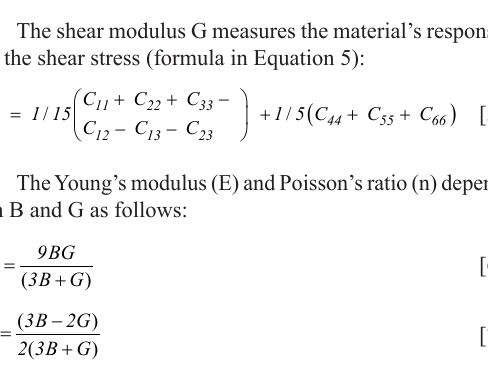
Figure 1. Two orientations of the crystal structure of marcasite (α-FeS S: yellow spheres).